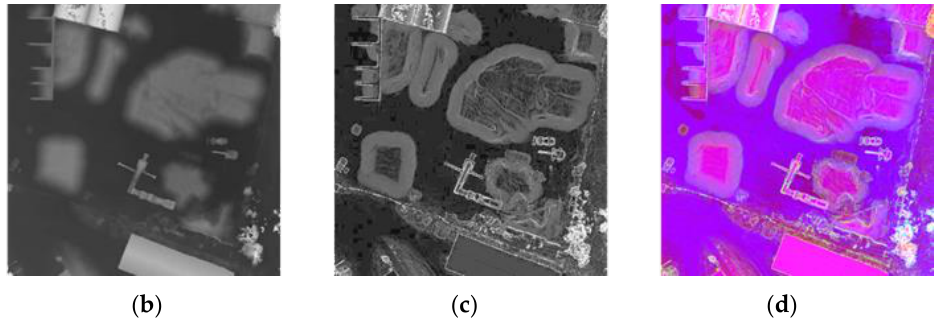
Figure 10. Aerial data of a stockpile site represented as ( a ) RGB orthomosaic as greyscale, ( b ) adjusted relative heights as greyscale, ( c ) local gradient, and ( d ) all three views stacked vertically along the channel dimension and displayed as RGB false color.